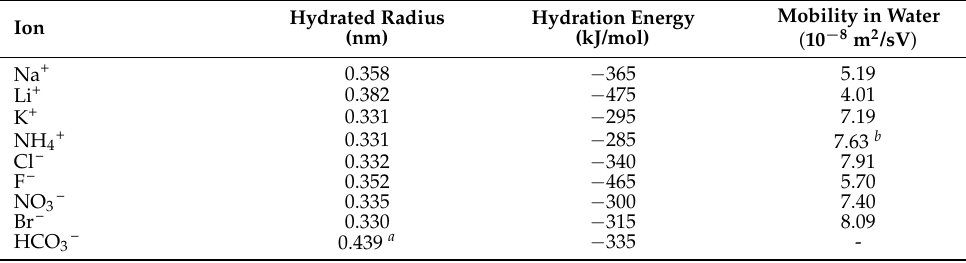
Table 5. Hydrated radii [135], hydration energy [136] and mobility in the water [137] of selected anions and